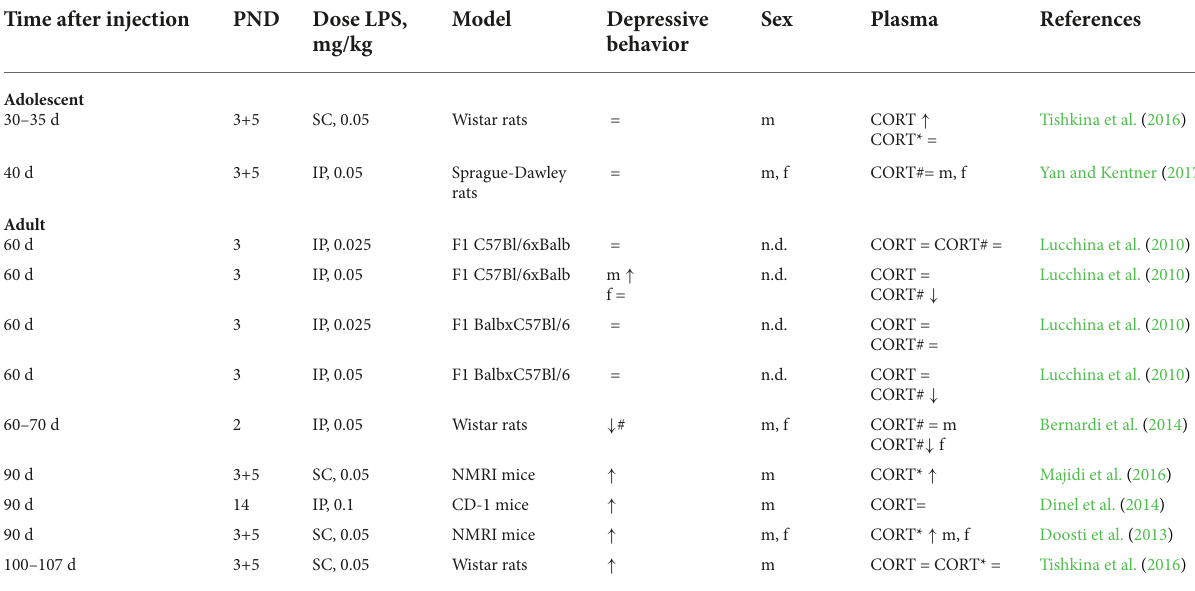
TABLE 4 Changes in corticosterone levels after neonatal